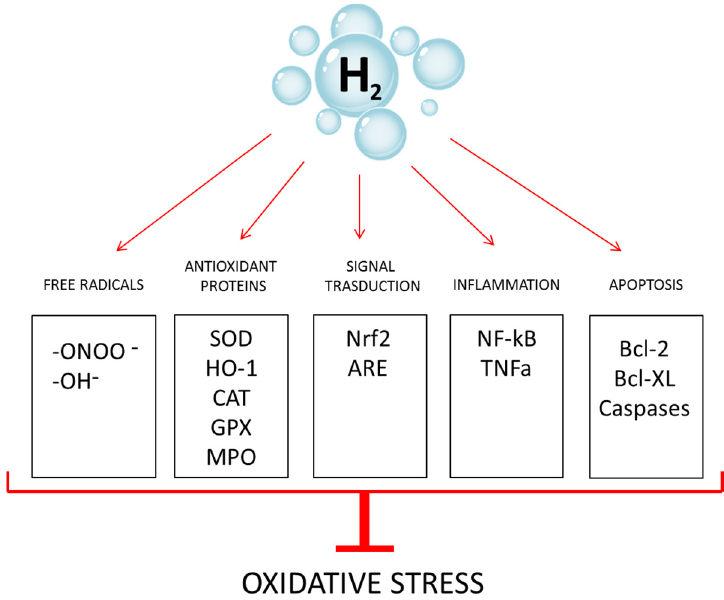
Figure 1. Molecular hydrogen counteracts oxidative stress through multiple pathways. -OH - : hydroxyl radical; -ONOO - : peroxynitrite anion; SOD: superoxide dismutase; CAT: catalase, MPO: myeloperoxidase; HO-1: heme oxygenase; ARE: antioxidant responsive element; GPX: glutathione peroxidase.